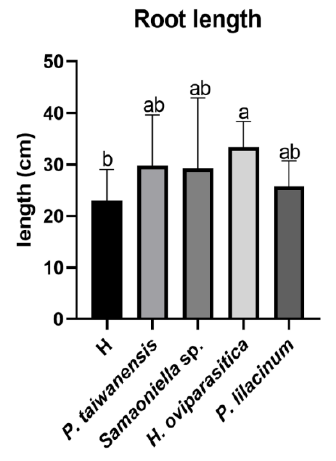
Figure 7. Root length promotion effect in the second greenhouse trial. H is the healthy control. Different letters indicate significant differences among treatments by Fisher’s LSD test ( P < 0.05), respectively.